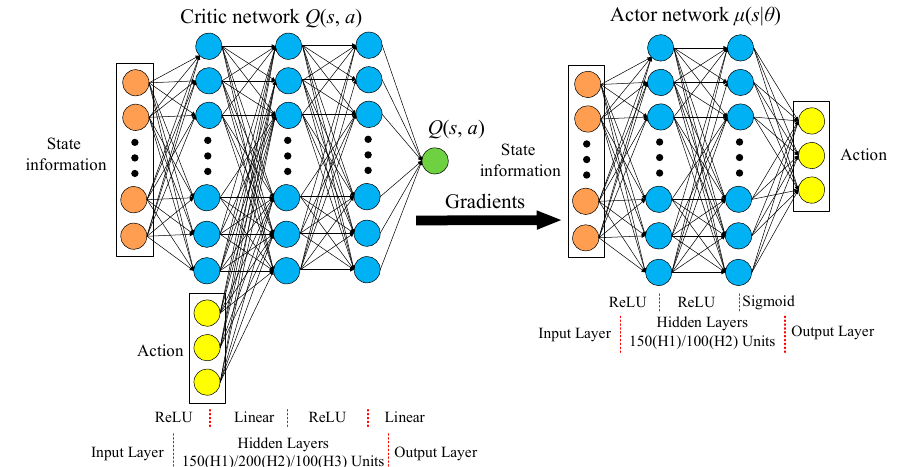
Figure 3. Actor-critic neural network structures for DDPG.